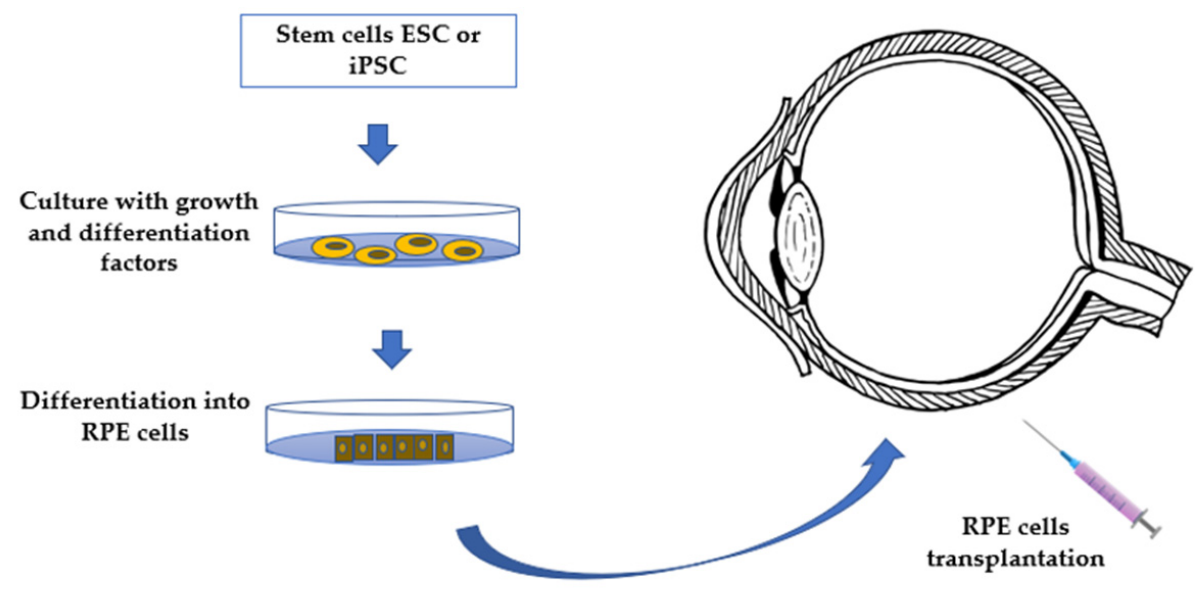
Figure 3. Stem cell therapy in AMD diagram [authors own drawing].